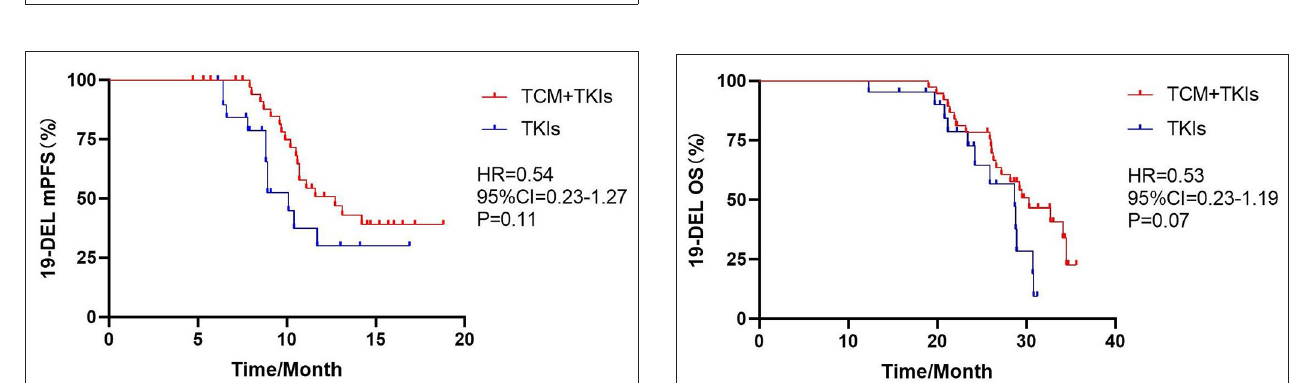
FIGURE 1 | Comparison of mPFS by two groups.